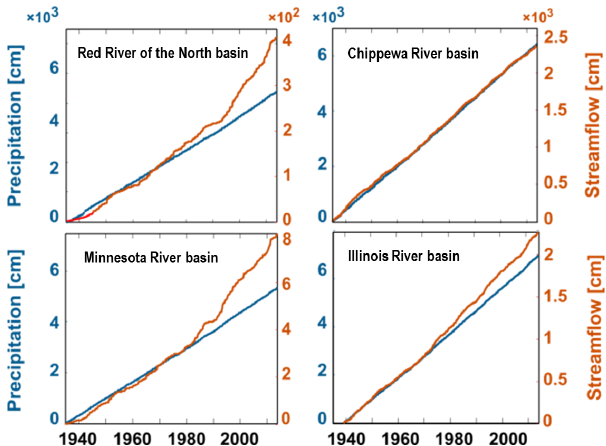
Figure 6. Cumulative monthly precipitation (blue) and stream- flow (red) depths (cm) for each river basin. Breakpoints, where the streamflow–precipitation relationship starts to change, are hard to detect from the time series alone, but can be clearly seen from the cumulative plots of the monthly data (i.e., when similar incre- ments of monthly precipitation are translated into larger amounts of monthly